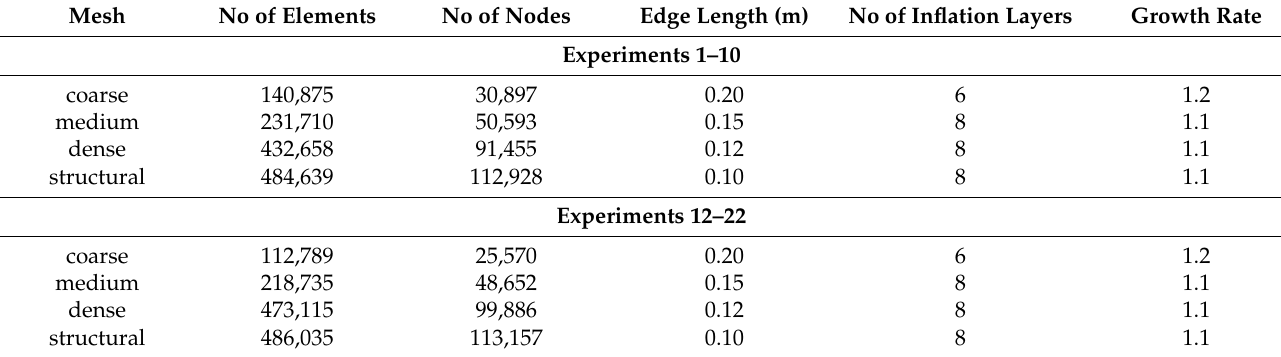
Table 5. The applied numerical meshes.